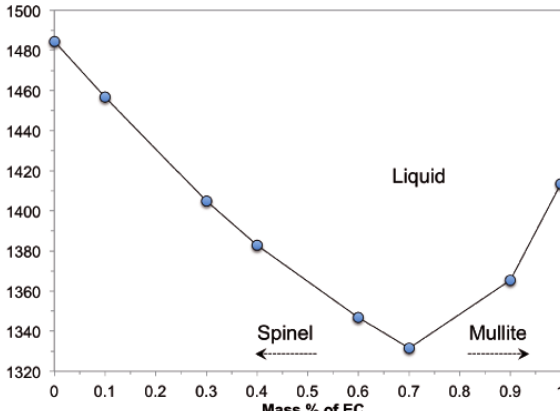
Fig. 9: The transition temperatures of the EC and WC blends as calculated using